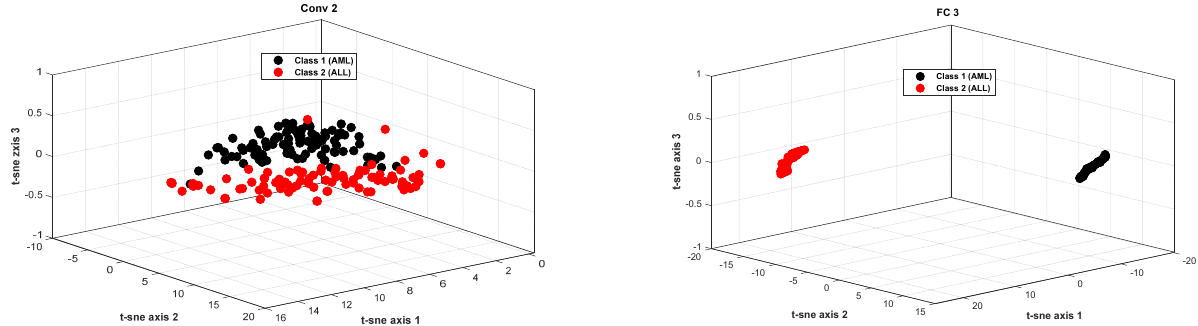
Figure 10. The visualization of the test data with the t-sen scatter.